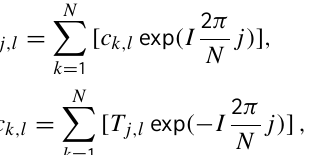
move usually in the direction from the northwest to south- east, or opposite as a typhoon in China, we put the 160 sta- tions into one dimension sequence in order of latitude,